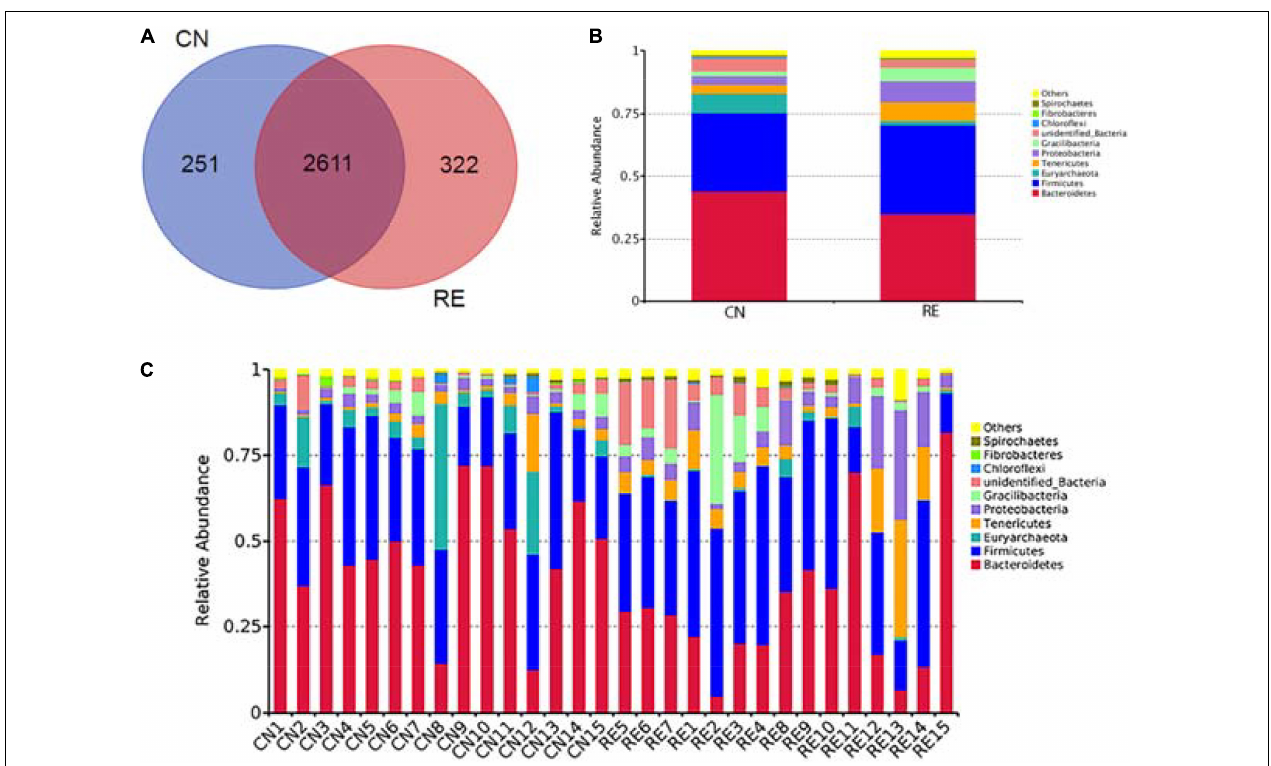
FIGURE 3 | Venn diagram representing the shared and exclusive OTUs at the 97% similarity level between rumen microbiota in the two groups (A) . Bar plot shows the relative abundance of rumen microbiota at the phylum level in each group (B) and in each sample (C) . OTUs, operational taxonomic units; CN, no herbal tea residue (control); RE, 50% HTR replaced Pennisetum purpureum .